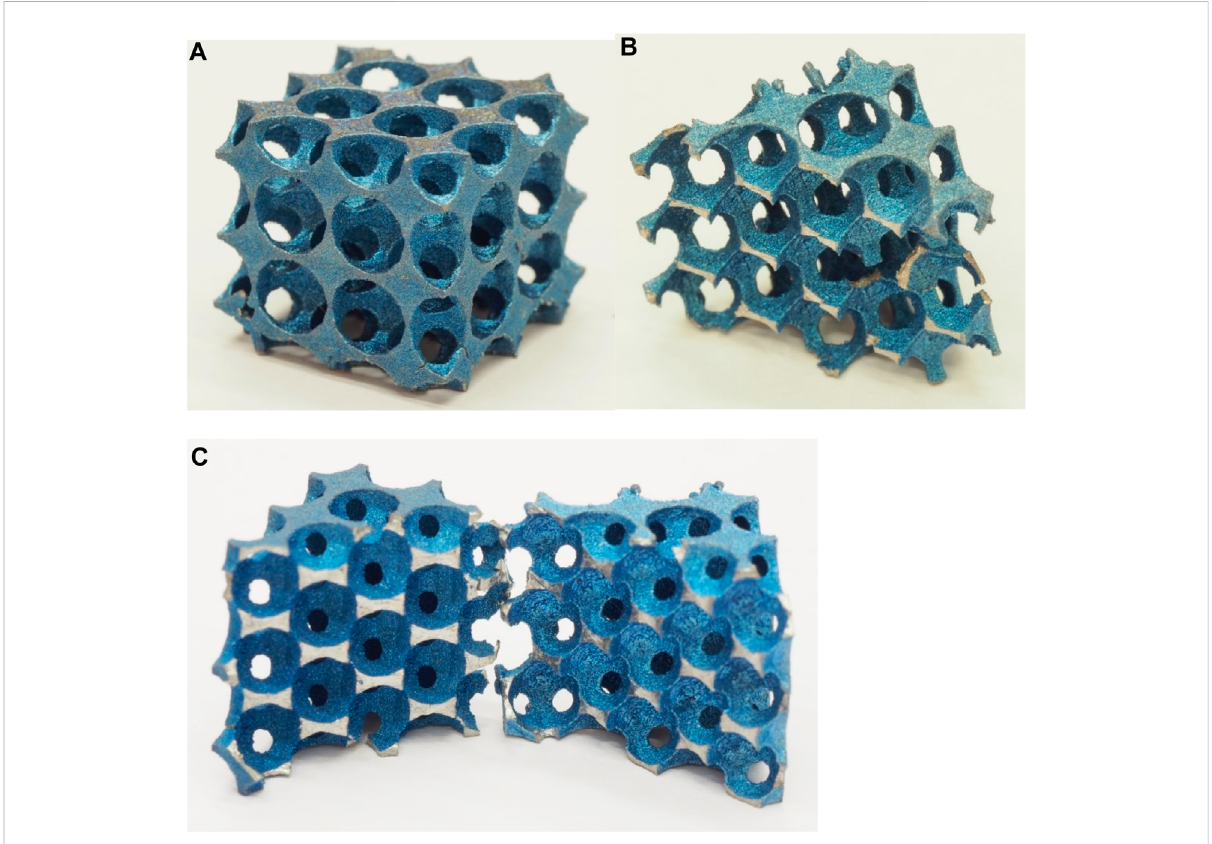
FIGURE 19 Photos of specimens: (A) Specimen no. 1 before the pressure test. (B) One broken half of Specimen no. 2. (C) The two broken pieces of Specimen no.